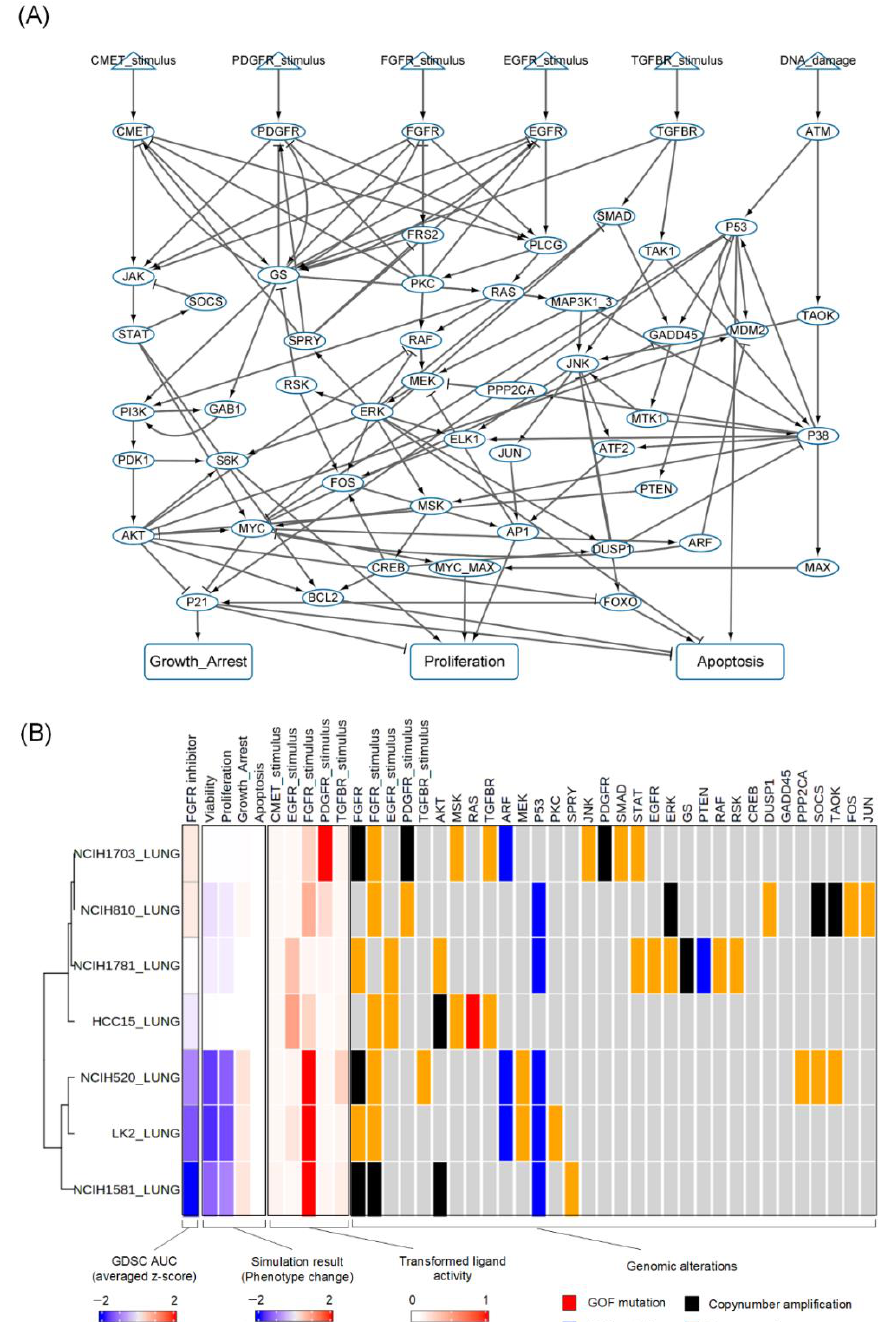
Figure 2. Reconstruction of lung cancer network model with cell line-specific genomic information and their predicted drug responses to FGFR inhibitor. ( A ) Our constructed lung cancer network with 59 nodes and their 138 molecular interactions created using public databases. There are a total of six nodes for input signals, including FGFR_stimulus, EGFR_stimulus, TGFBR_stimulus CMET_stimulus, PDGFR_ stimulus, TGFB_stimulus, and DNA damage. There are three output nodes, including proliferation, apoptosis, and growth arrest. ( B ) Seven cell line-specific lung cancer network models are shown. Responses of the corresponding cell lines from the GDSC to FGFR inhibitors are shown in the first column. Simulation results of the predicted responses to FGFR inhibitor are shown in the next column. Genomic alteration information and activities of the network components from the corresponding cell line-specific network models are